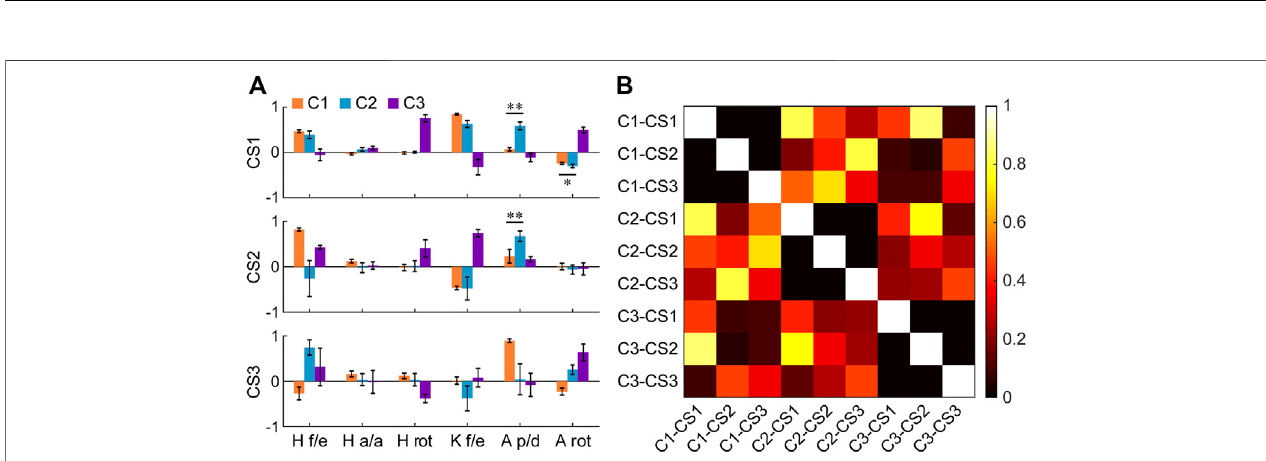
Frontiers in Bioengineering and Biotechnology |